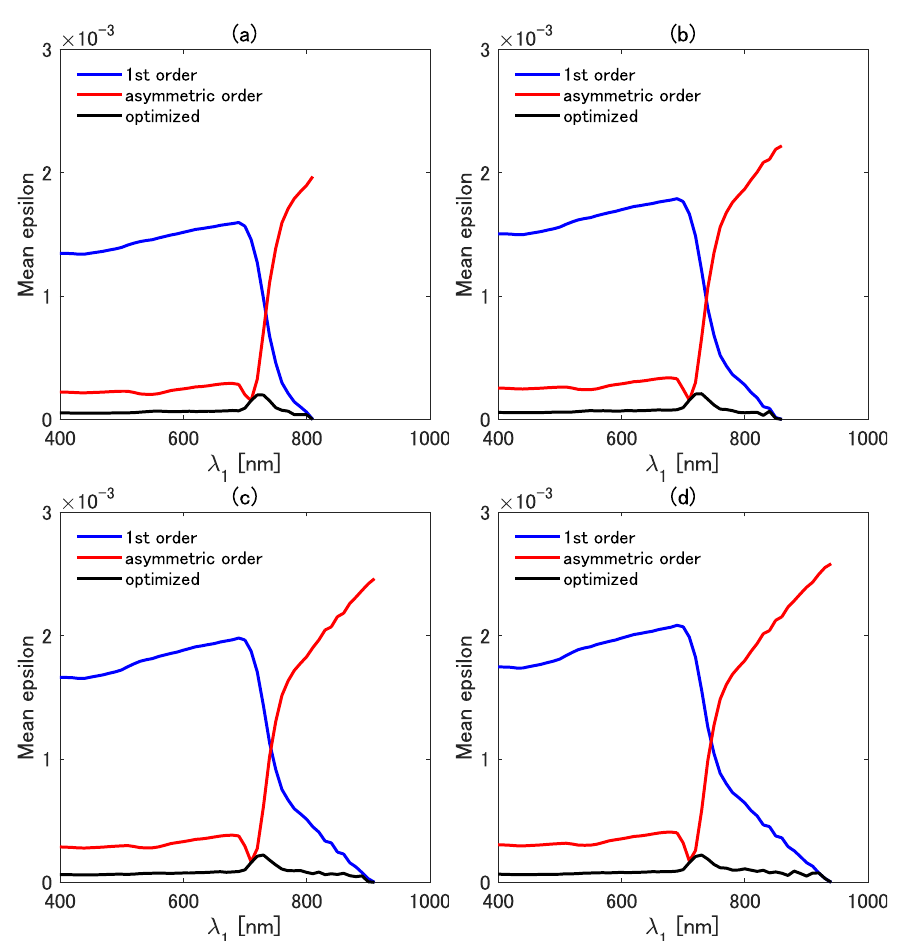
Figure 7. Comparisons of the mean epsilon among the first-order, the asymmetric-order, and the optimized asymmetric-order isolines as a function of λ 1 at four fixed values of λ 2 : ( a ) 810 nm, ( b ) 860 nm, ( c ) 910 nm, and ( d ) 940 nm. Similar comparisons were made for the mean epsilon of the three types of